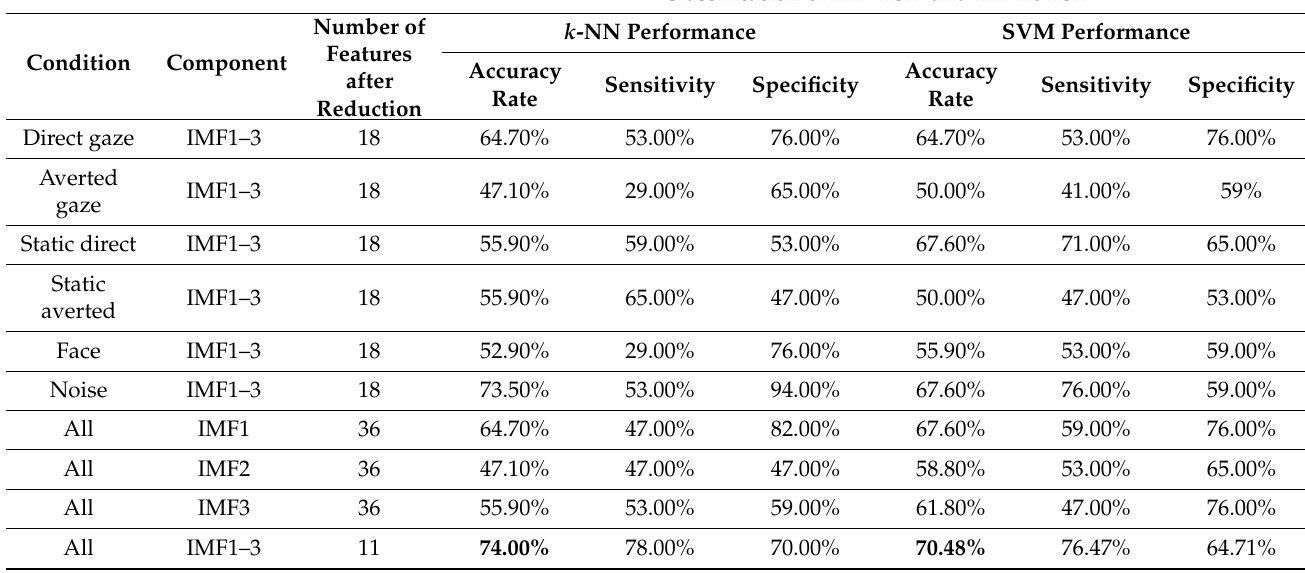
Table 3. For the classification of the diagnosis outcome: comparison between k -NN and SVM classifiers of accuracy rates, specificity, and sensitivity. The first six rows represent the results of the analysis of the six stimulus conditions separately. Rows 7, 8, and 9 show the classification performance when using features extracted from one IMF at a time. Row 10 represents the results of analysis of the six stimulus conditions together with the IMFs with 11 selected features by weight correlation. Best accuracies of 74% and 70.48% were obtained using k-NN and SVM